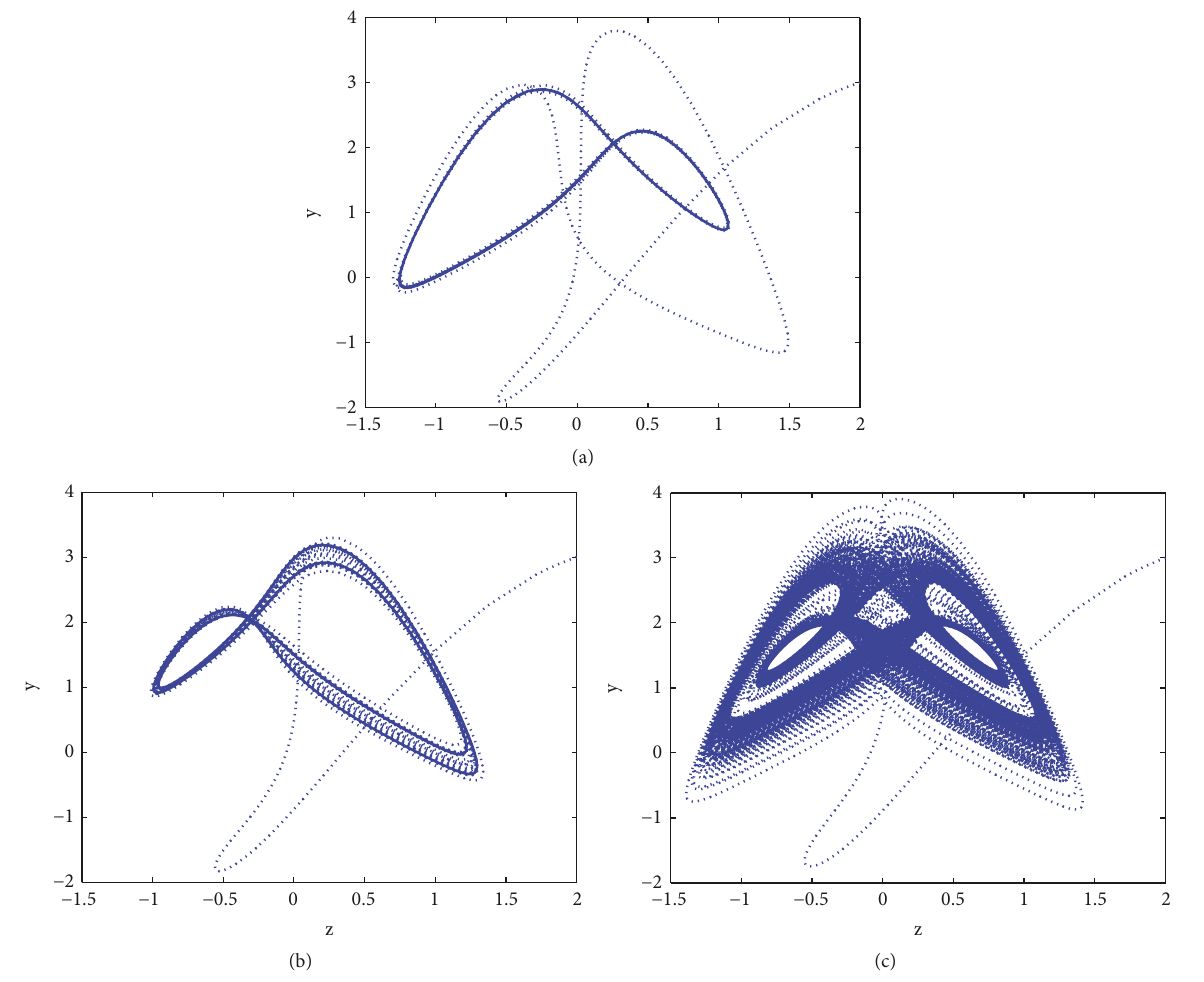
Figure 15: For (a), 𝑏 = 0.01 . For (b), 𝑏 = 0.1 . For (c), 𝑏 = 0.2 .